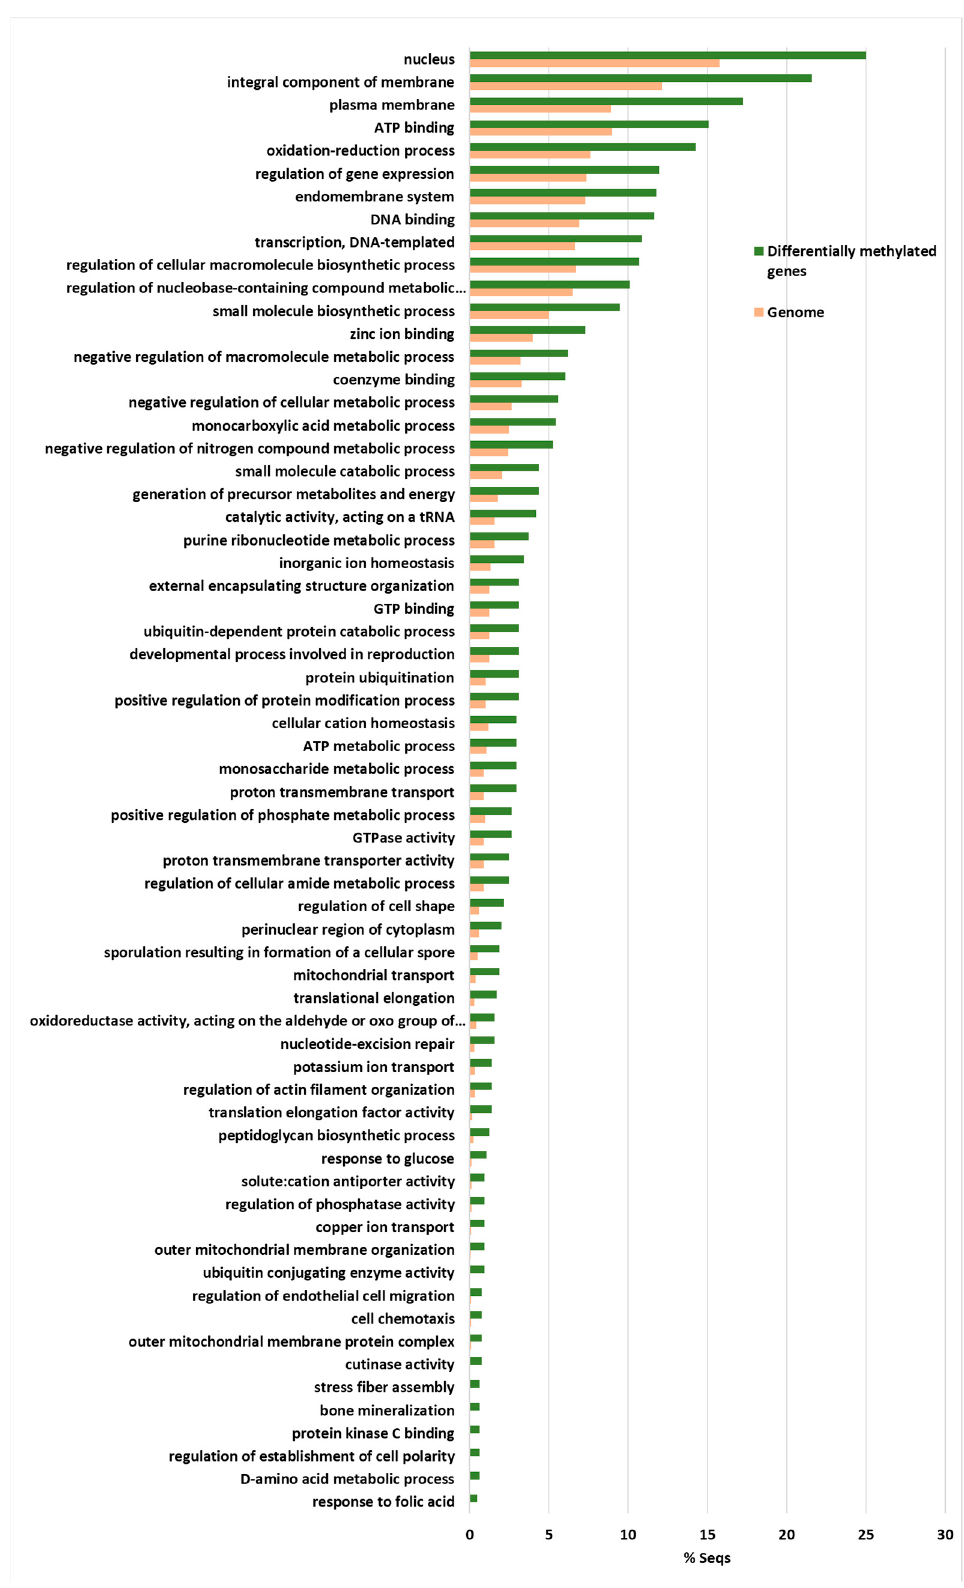
Figure 6. The Fischer exact test-enriched GO terms of genes displaying an inverse pattern of virulence and DNA methylation in the Verticillium dahliae D isolates. The 831 genes that fulfilled the criteria of being at least 1% more methylated in V937I that in the more virulent V937I-HP and V150I isolates, and 1% less methylated in V937I than in the less virulent V403I and V138I, are represented. The methylation differences between isolates for each gene was calculated from average data in the biological replicates.